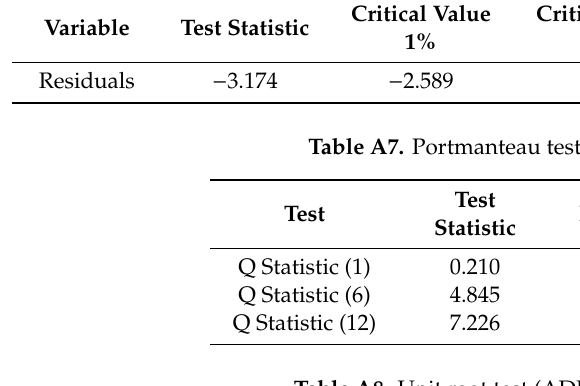
Table A8. Unit root test (ADF).